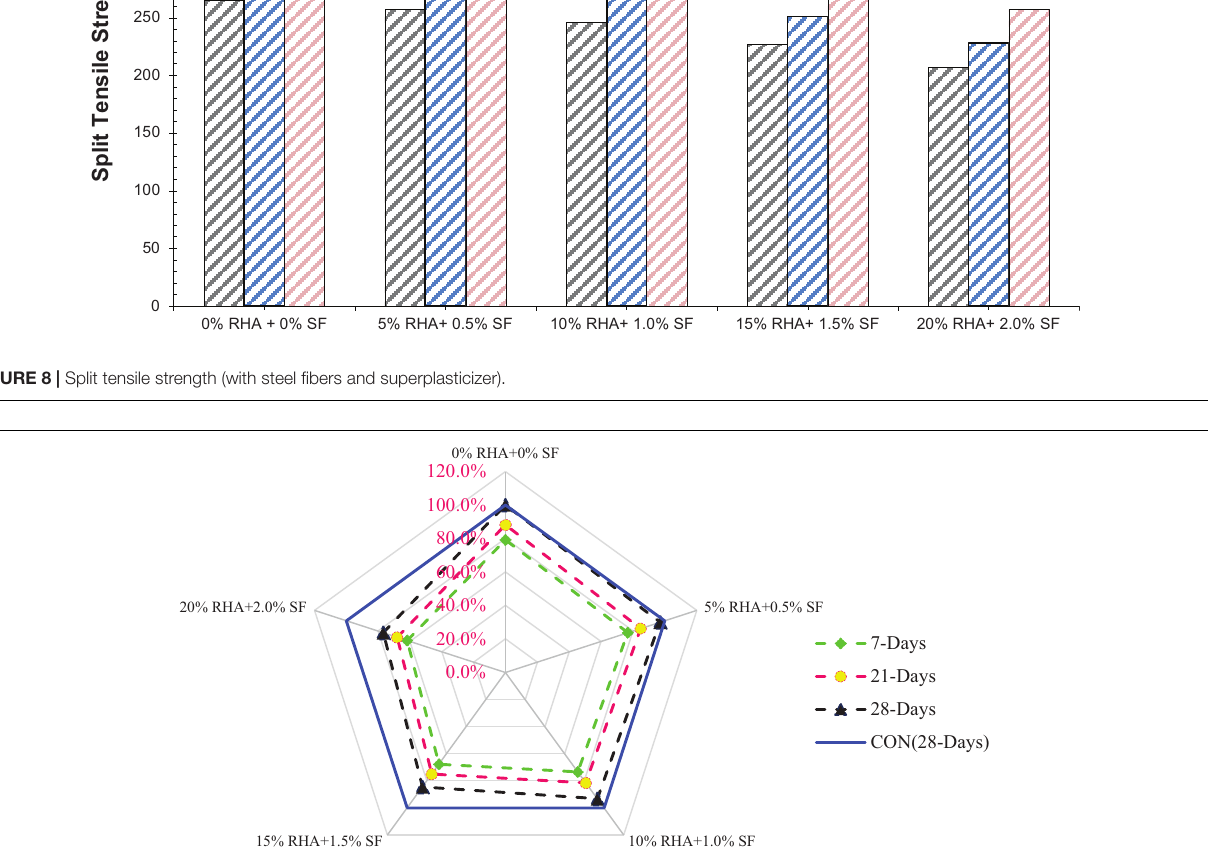
FIGURE 9 | Relative analysis split tensile strength (with steel fibers and super